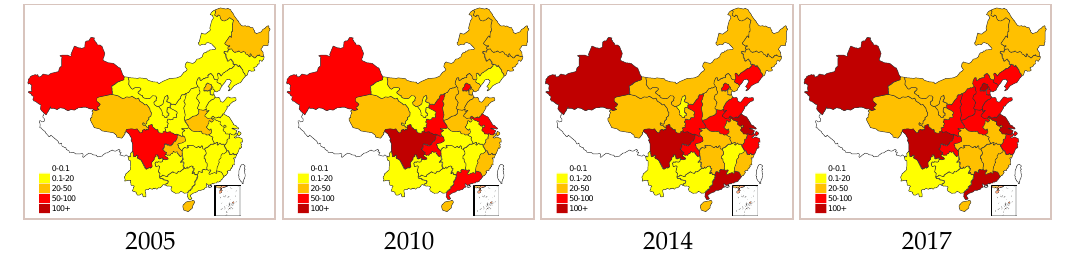
Figure 1. Temporal and spatial evolution of natural gas consumption in China.